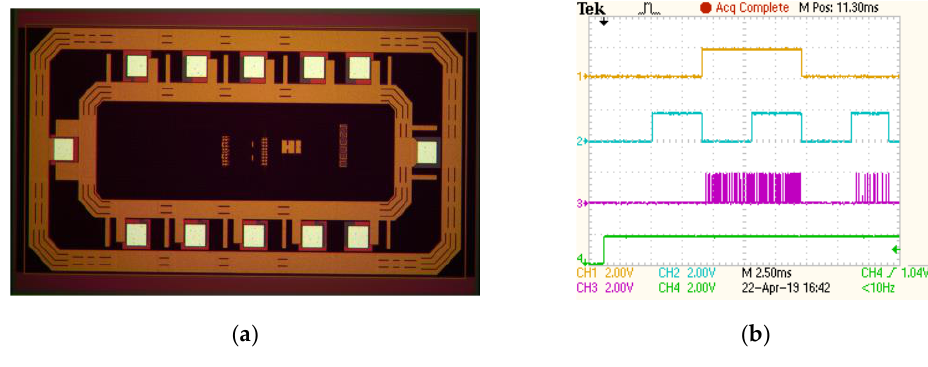
Figure 7. ( a ) Micrograph ( b ) test result of the Pavlov SNN chip.